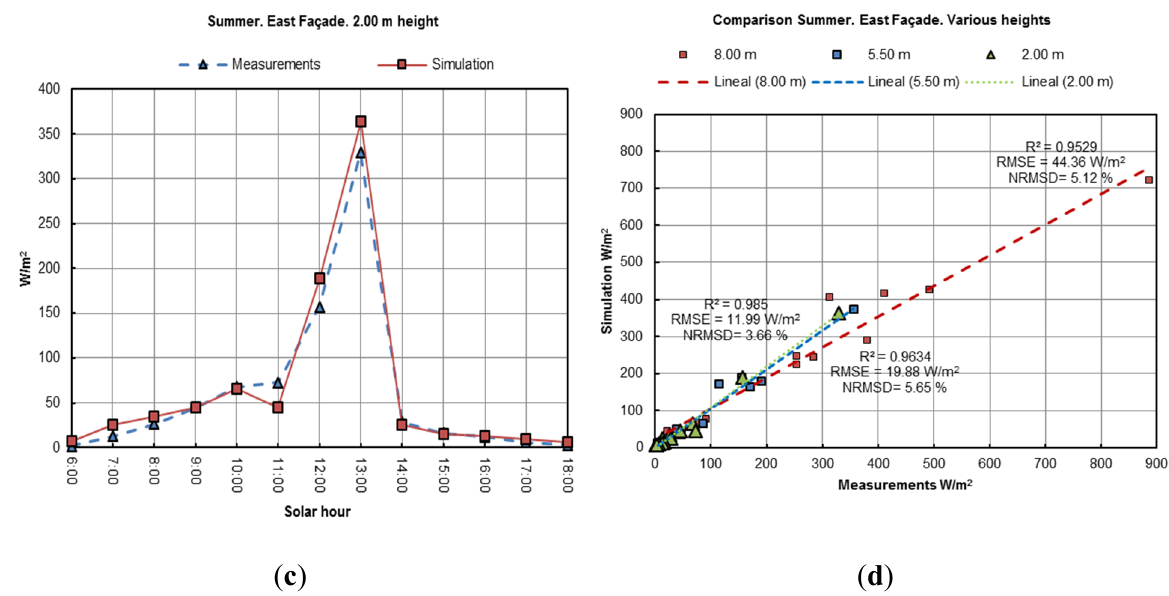
Figure 10. 24 h comparison between cell measurements and simulations, summer. East façade. Seville. ( a ) 8.00 m height; ( b ) 5.50 m height; ( c ) 2.00 m height; ( d ) Correlation R 2 , RMSE and NRMSD between cell measurements and